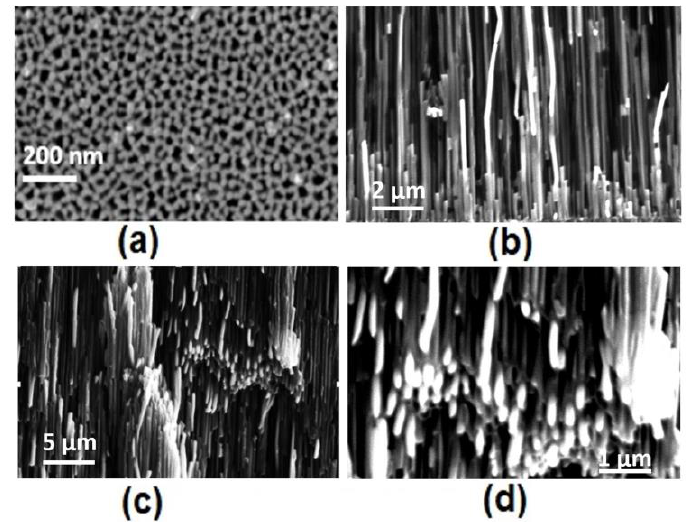
Figure 5. Field emission scanning electron microscope (FESEM) micrograph of random oriented nanorods at potential of − 0.5 V ( a ) top view of the AAO template, ( b ) cross section of the AAO template, ( c ) cross-section of AAO template at another location, and ( d ) higher resolution image of ( c ).